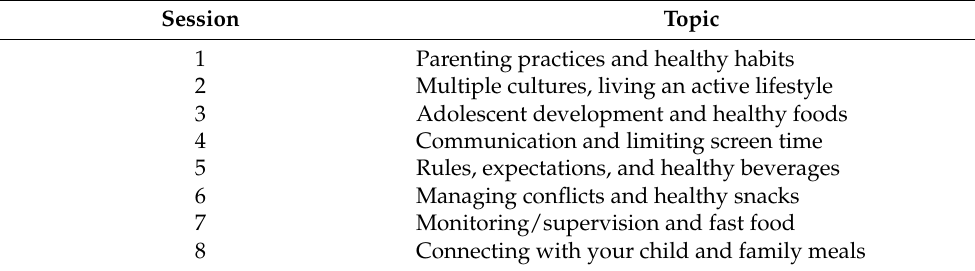
Table 1. A list of the topics by week in the parent sessions. Session Topic 1 Parenting practices and healthy habits 2 Multiple cultures, living an active lifestyle 3 Adolescent development and healthy foods 4 Communication and limiting screen time 5 Rules, expectations, and healthy beverages 6 Managing conflicts and healthy snacks Monitoring/supervision and fast food Connecting with your child and family